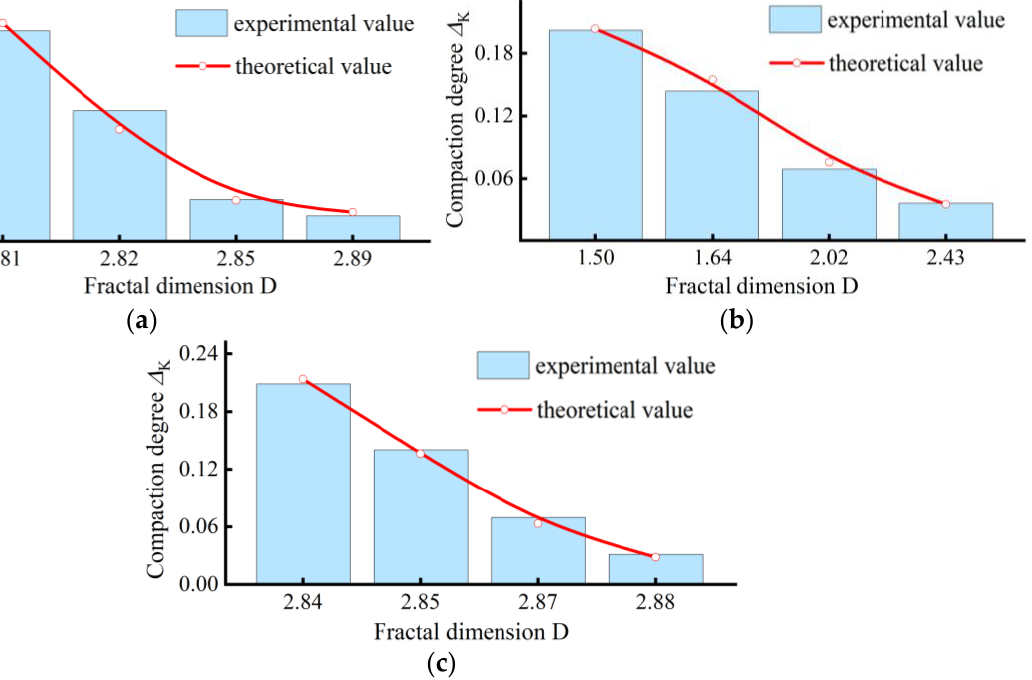
Figure 12. Relationship between compaction increment and fractal dimension. ( a ) Continuous grading structure; ( b ) intermittent 0–5 mm particle size grading structure; ( c ) intermittent 15–20 mm particle size grading